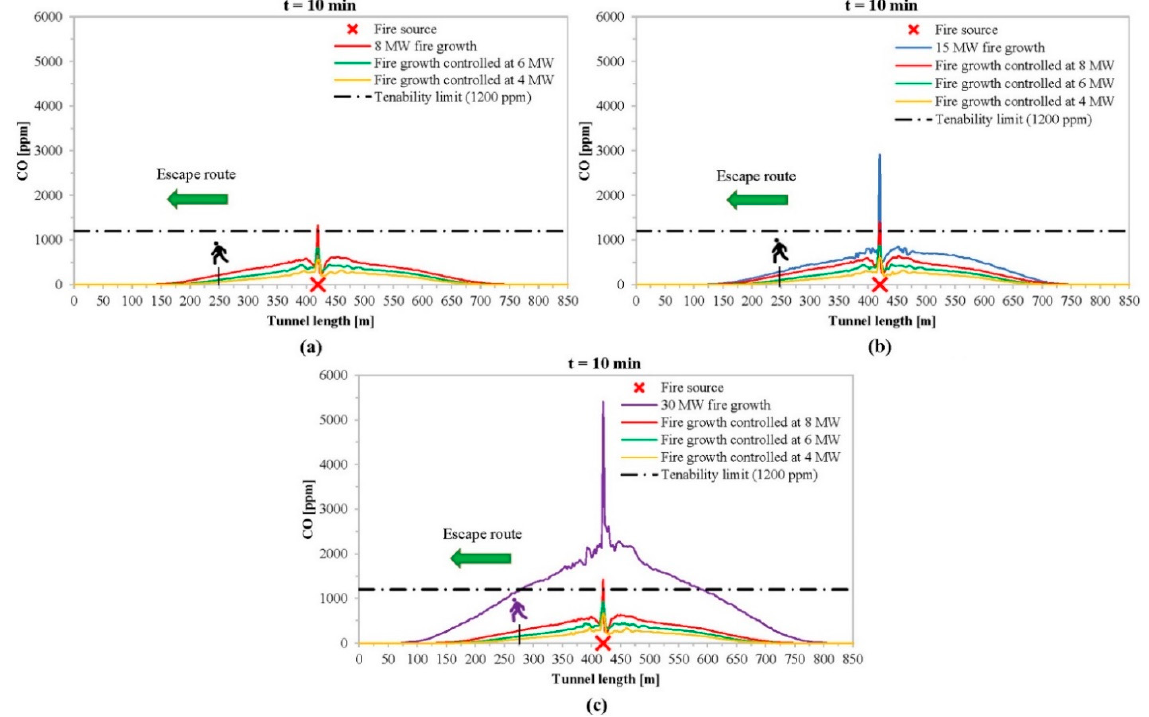
Figure 14. Profiles of longitudinal CO concentration at a height of 2 m along the escape route on the road carriageway after 10 min from the fire’s start when the burning vehicle is at 420 m from portal A and the micronized water system is activated before that the fire growth achieves values of: ( a ) HRR max = 8 MW, ( b ) HRR max = 15 MW, ( c ) HRR max = 30 MW.